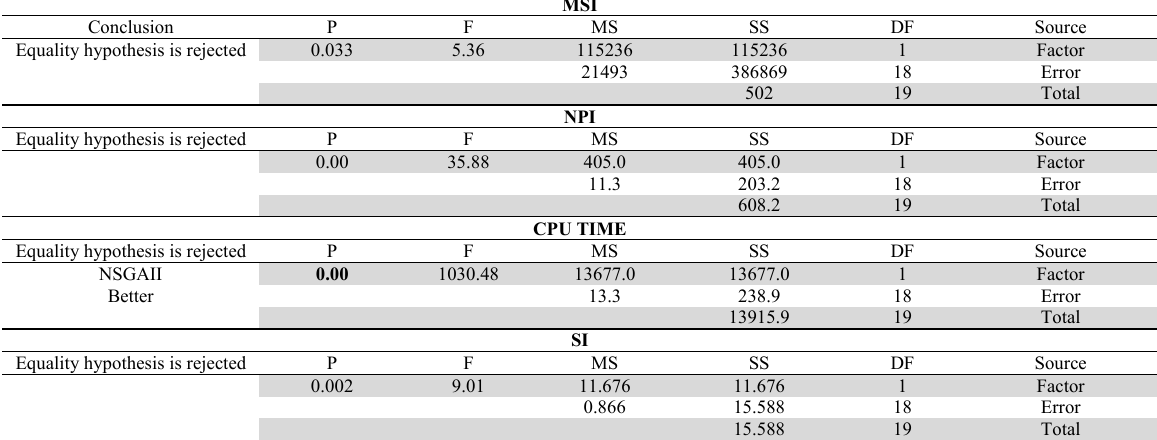
The summary of the results of one-way ANOVA test on NSGA II versus MOPSO for large